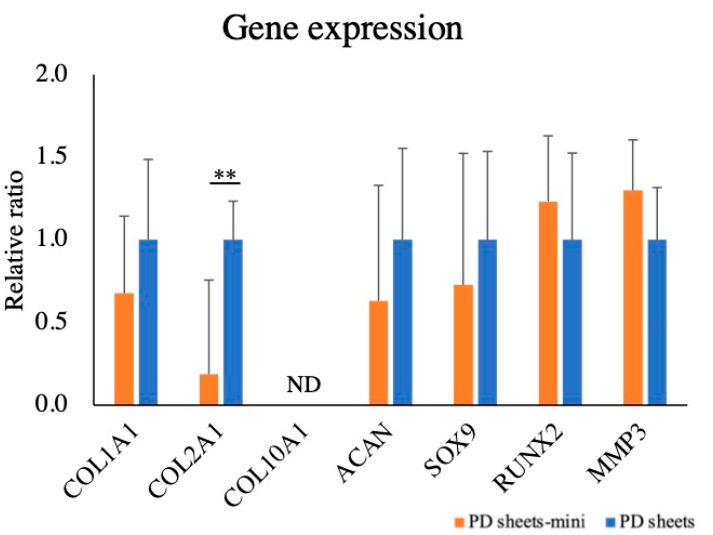
Figure 5. Cartilage-related gene expression analysis in PD sheets and mini PD sheets. The relative gene expression of PD sheets was set at 1.0. The values are expressed as mean ± standard deviation. ** p < 0.01; ND, not detected. Only the expression of COL2A1 differed between PD sheets and mini PD sheets.